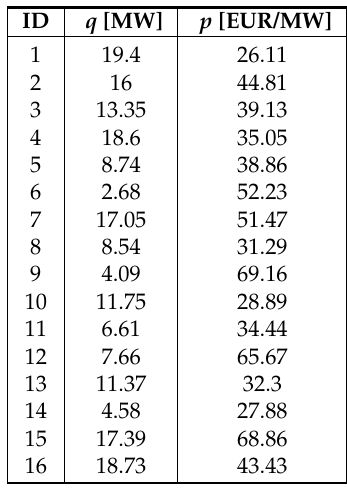
Table A5. Reference (non-SRDB) RS- bid set: The columns correspond to the index of the bid (ID), quantity ( q ) and bid price ( p ) respectively. The SRDB bids are generated according to u , and the implied actual set of uncertain energy